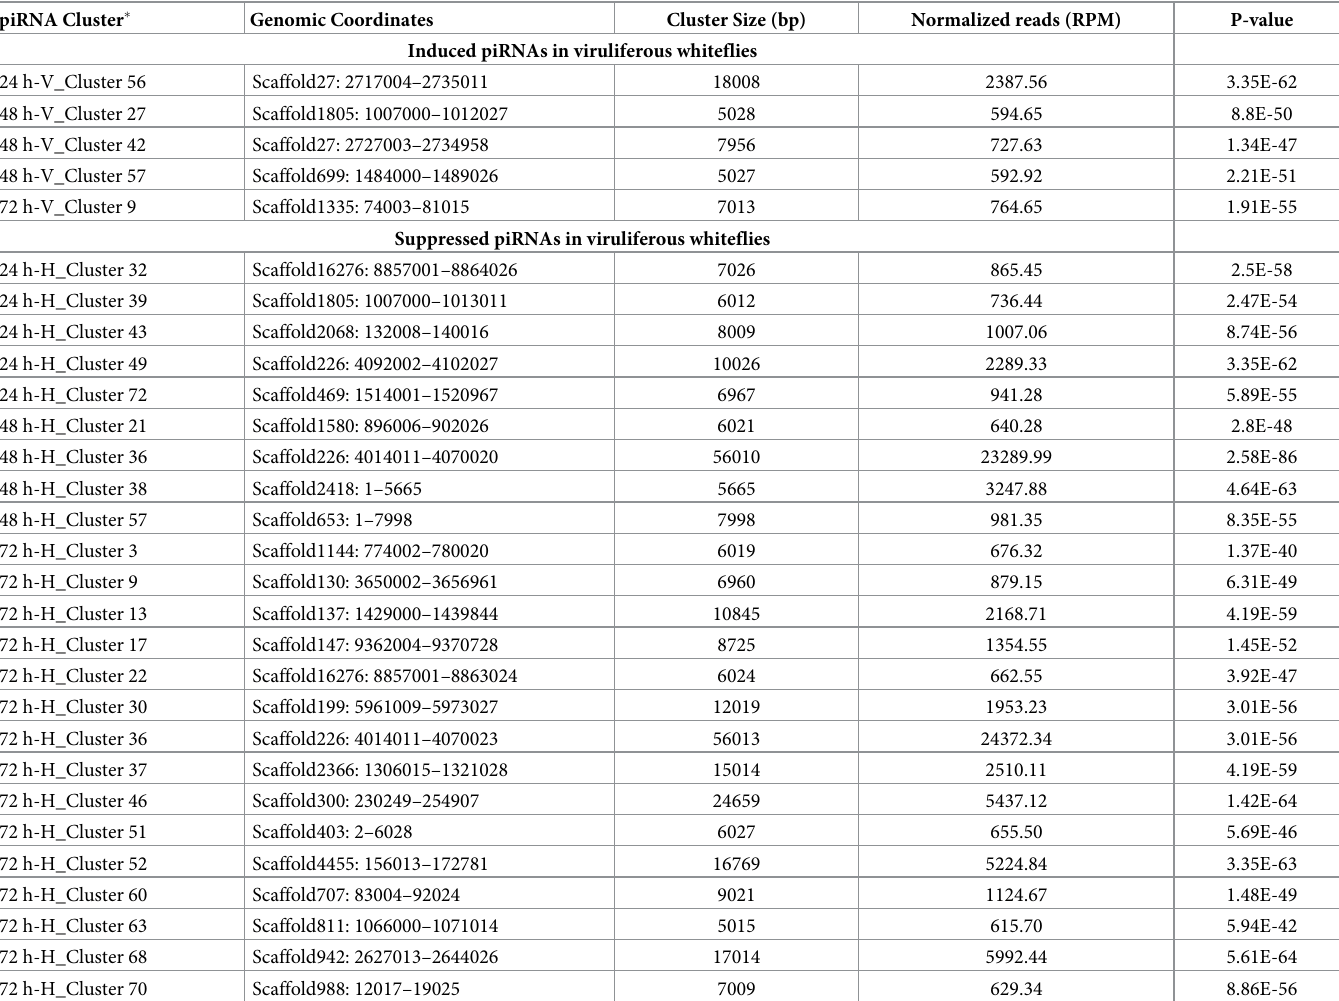
Table 4. Primary piRNA clusters induced or suppressed upon TYLCV